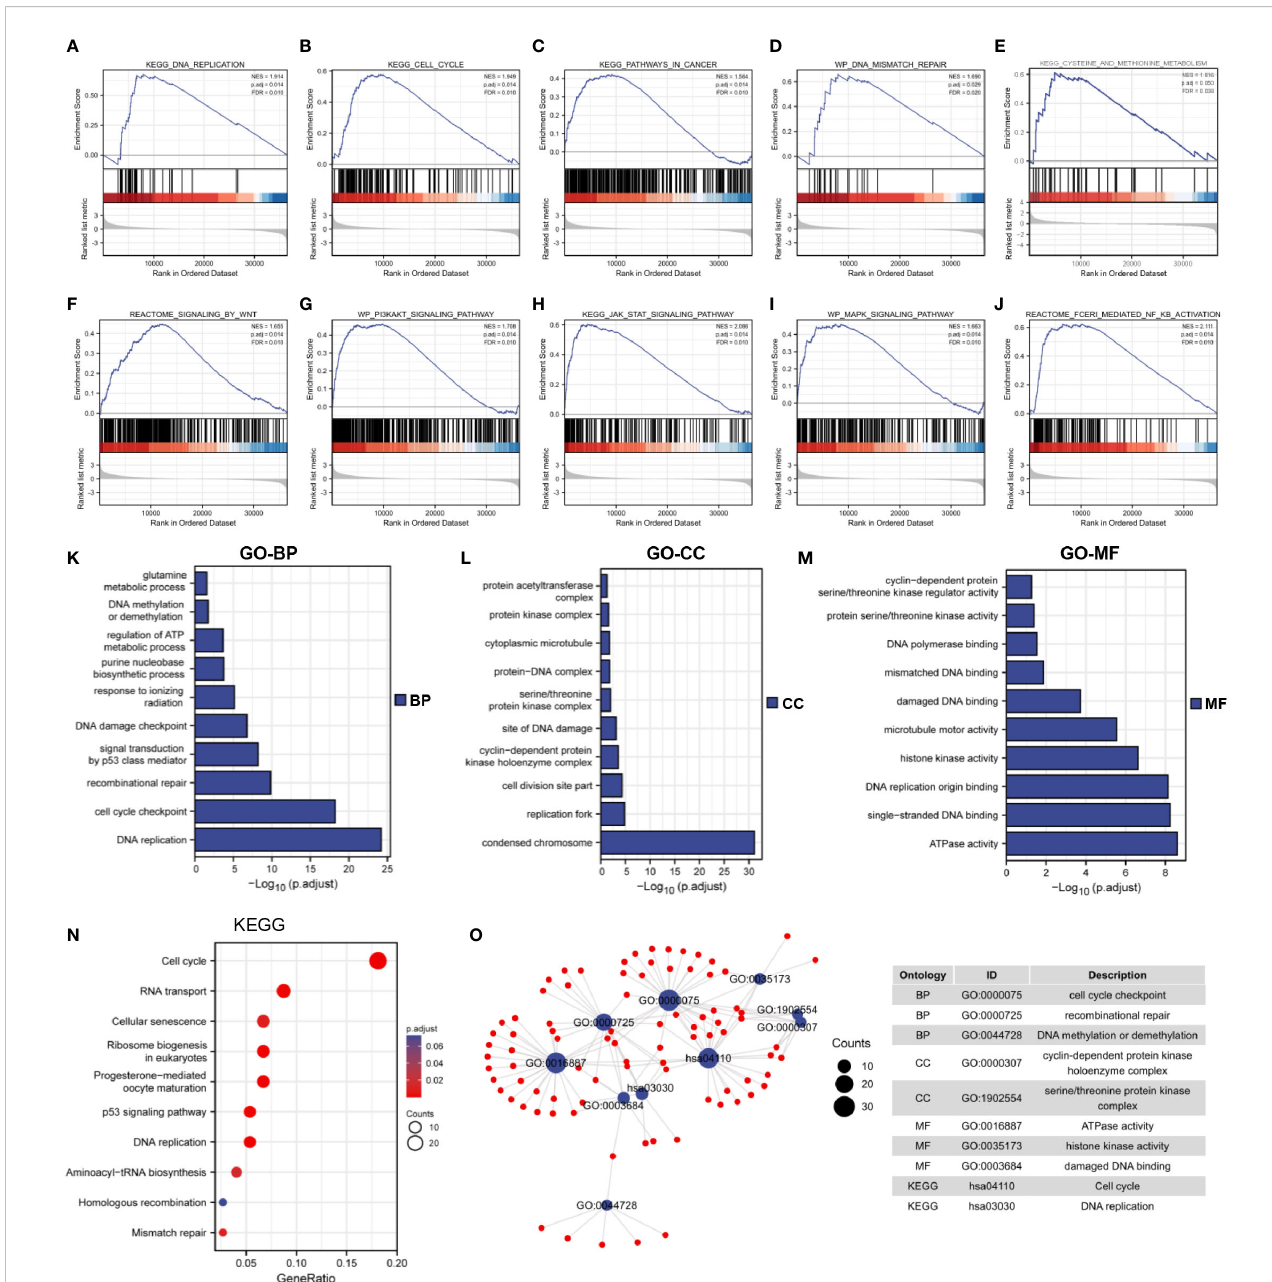
FIGURE 6 Functional enrichment analysis. (A – J) GSEA enrichment analysis identi fi ed the biological signature in breast cancer. (A) DNA replication, (B) cell cycle, (C) cancer pathways (D) DNA mismatch repair, (E) methionine metabolism, (F) Wnt signaling, (G) PI3K-AKT signaling, (H) JAK-STAT signaling, (I) MAPK signaling, (J) NF- k B signaling. ES, enrichment score; NES, normalized ES; NOM p-Val, normalized p-value; FDR, False Discovery Rates. (K – M) GO enrichment analysis of 300 top co-expressed genes in breast cancer. (K) biological processes (BP), (L) cellular components (CC), (M) molecular functions (MF). (N) KEGG enrichment analysis of 300 top co-expressed genes in breast cancer. (O) Network diagram of GO and KEGG pathway in top 10 tumor- related terms. Ontology, ID, and description of terms are shown in the